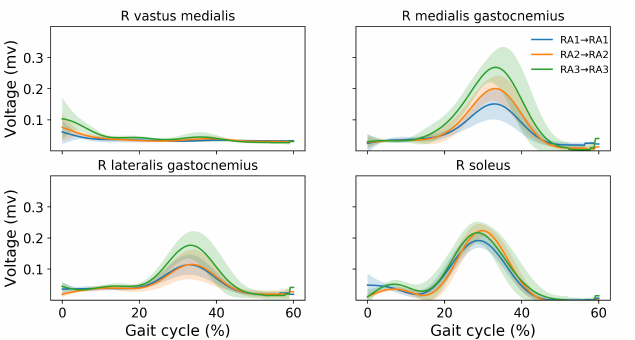
Figure A1. EMG recordings of the vastus medialis, medialis gastocnemius, lateralis gastocnemius, and soleus in the right limb under different ramp ascent transitions RA1 → RA1, RA2 → RA2, and RA3 → RA3 of a representative